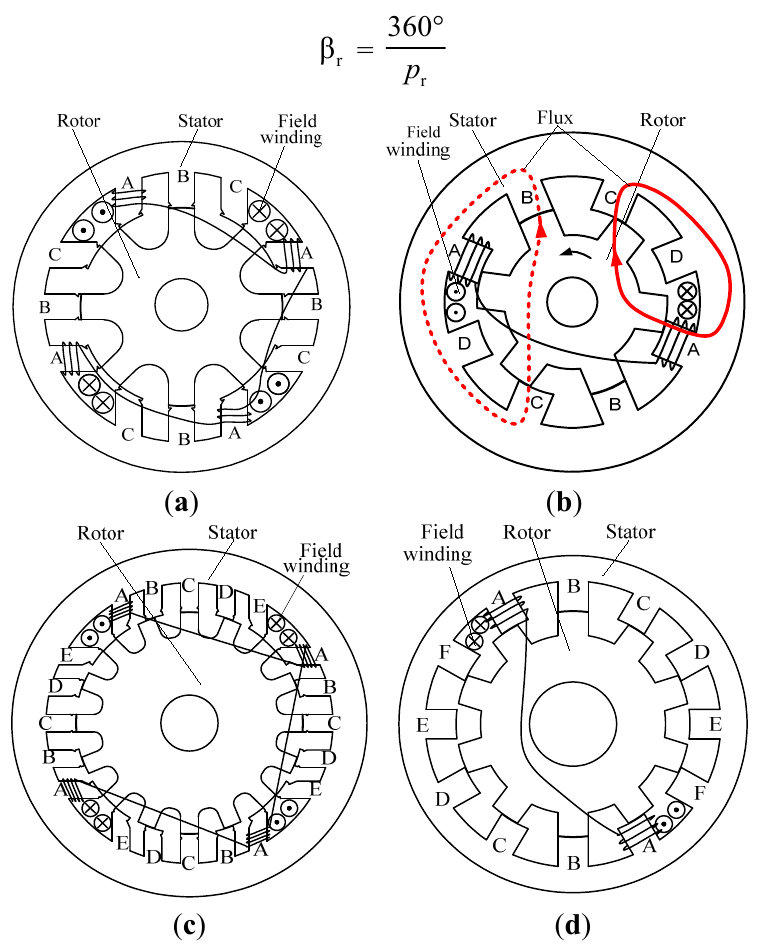
Figure 1. Structure of the three-phase and multiphase DSG. ( a ) 12/8-pole three-phase of WFDSM; ( b ) 8/6-pole four-phase; ( c ) 20/16-pole five-phase; ( d ) 12/10-pole